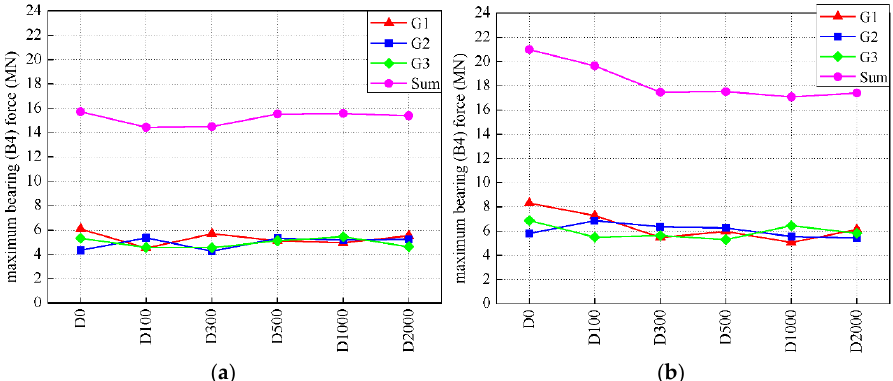
Figure 14. Maximum pounding forces between roller bearing (B4) and stopper in tangential direction. ( a ) Stopper = 4 cm. ( b ) Stopper = 8 cm.